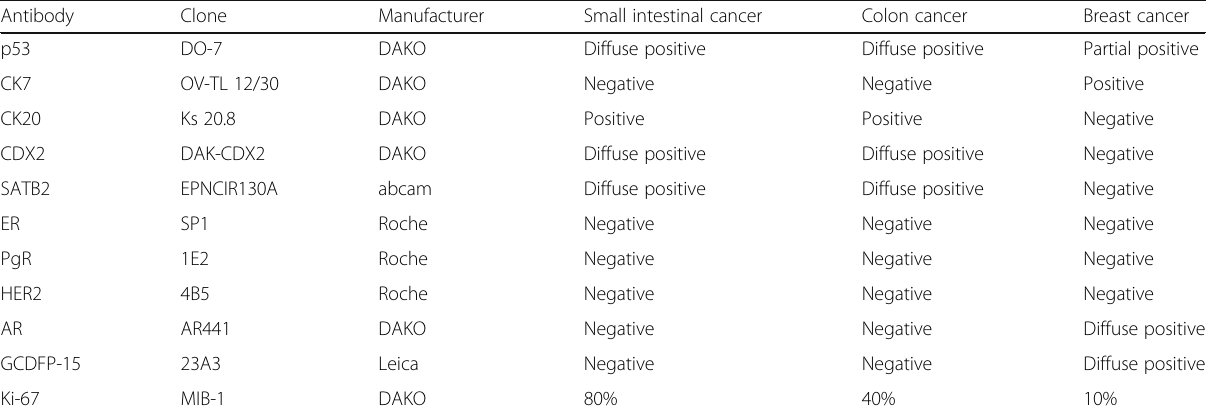
Table 1 Summary of immunohistochemistry in the present case Antibody